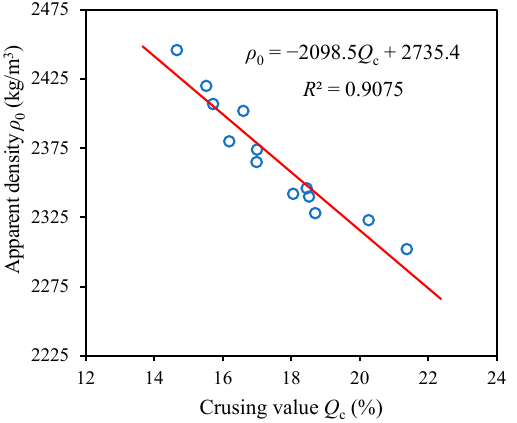
Figure 7. Relationship between the apparent density ρ 0 and crushing value Q c .